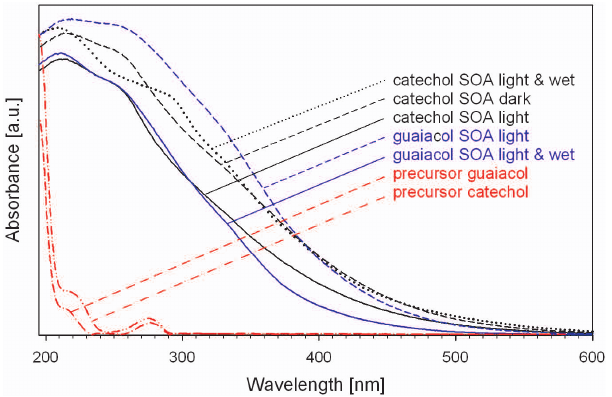
Fig. 9. Diffuse reflectance UV/VIS spectra of SOA from catechol and guaiacol and absorption spectra of the pure compounds.